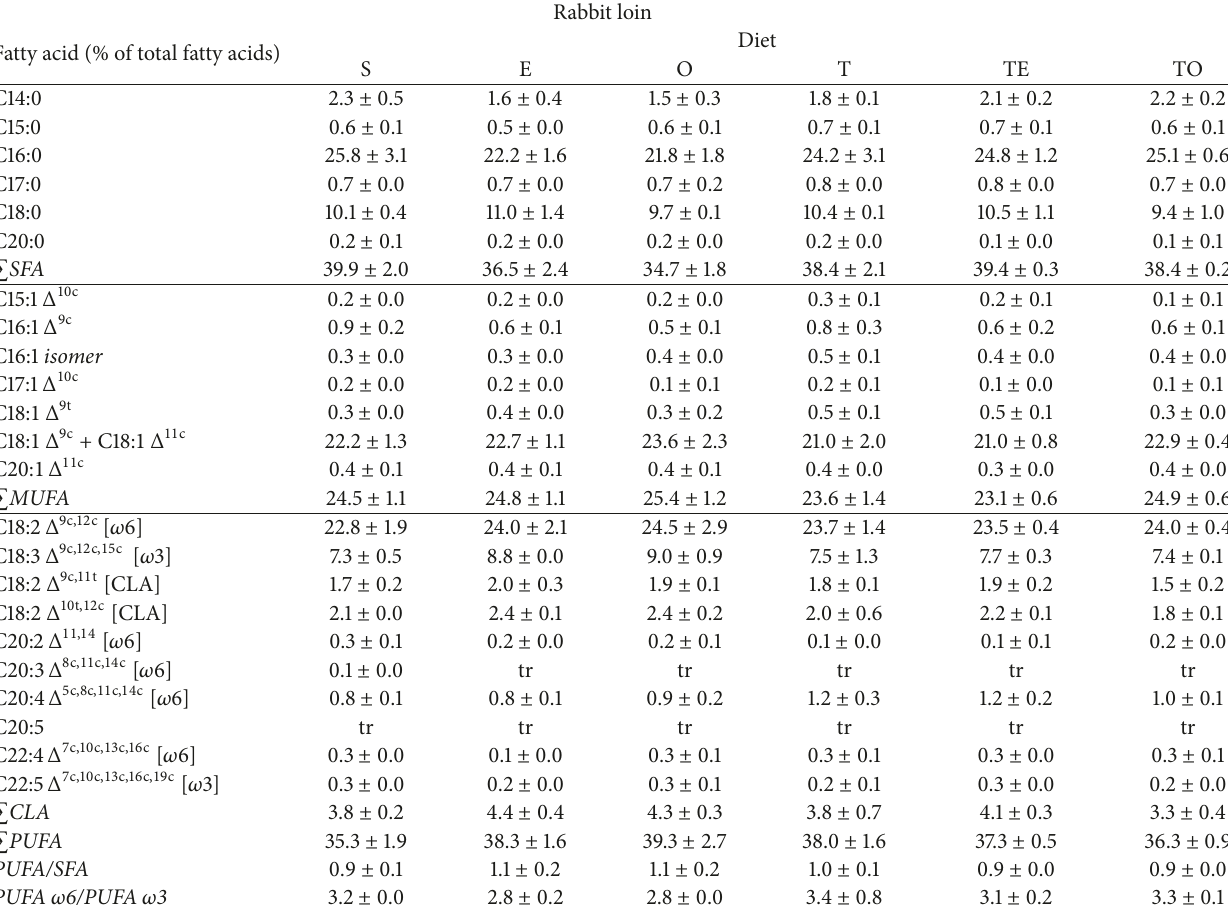
Table 4: Fatty acid composition of rabbit loin belonging to different dietary groups. Rabbit